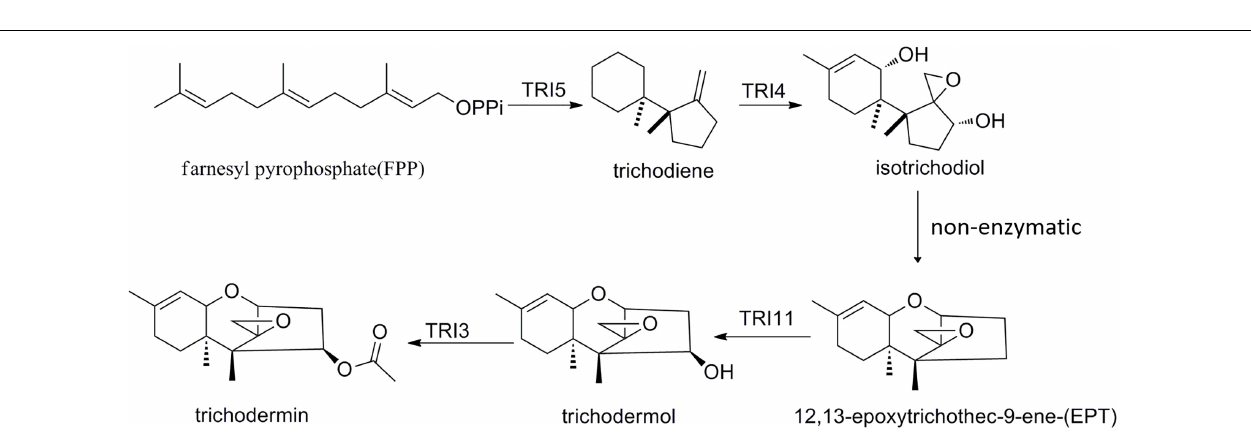
FIGURE 7 | Comparison of TRI genes expression level between wild-type strain and (cid:49) TtTRI3 . Expression level for TRI genes was determined by qRT-PCR. Expression level of genes in ZJUF0986 was normalized as 1. Calculation was based on data obtained from three independent experiments.